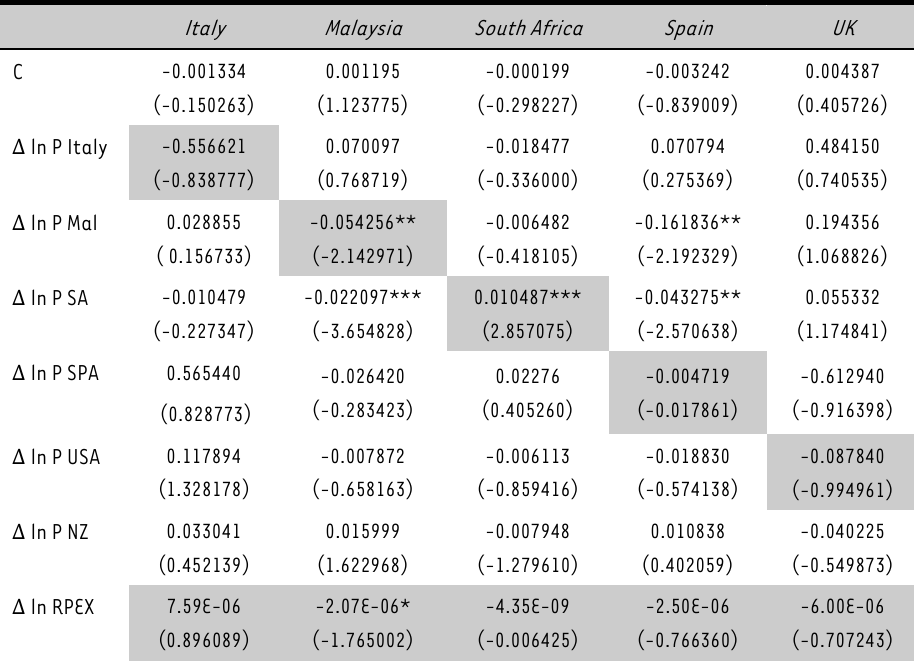
Unrestricted AIDS model for USA